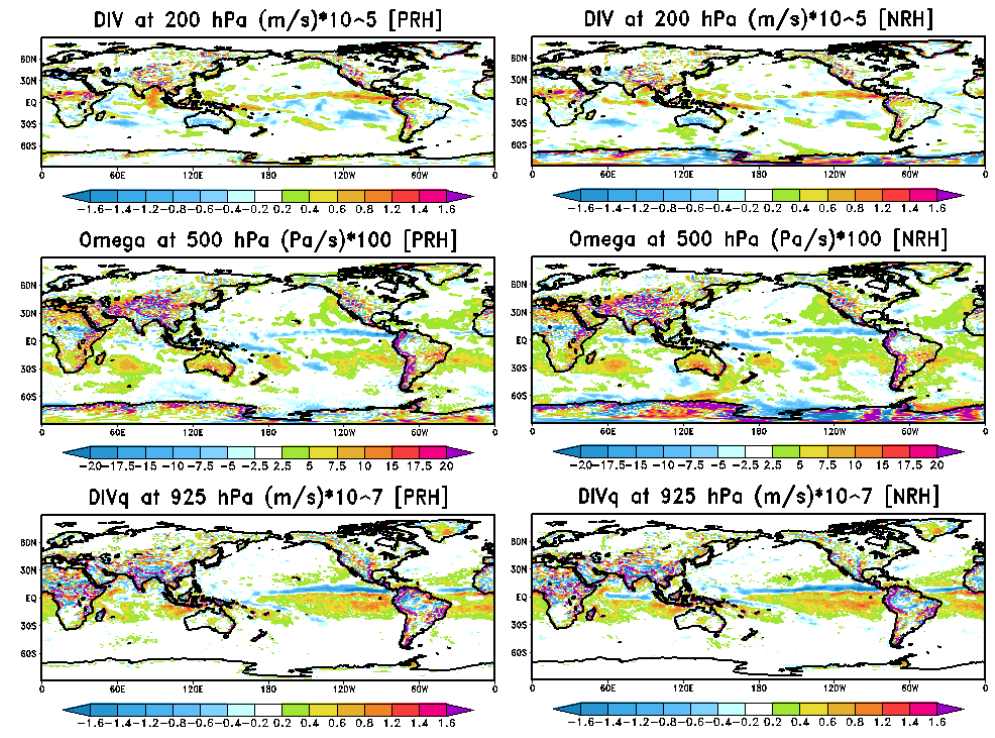
Figure 2. The mean fields of the initial condition of divergence fields in 200 hPa, vertical movement in 500 hPa, and humidity flow divergence in 925 hPa during the experiments that utilized PRH and NRH in